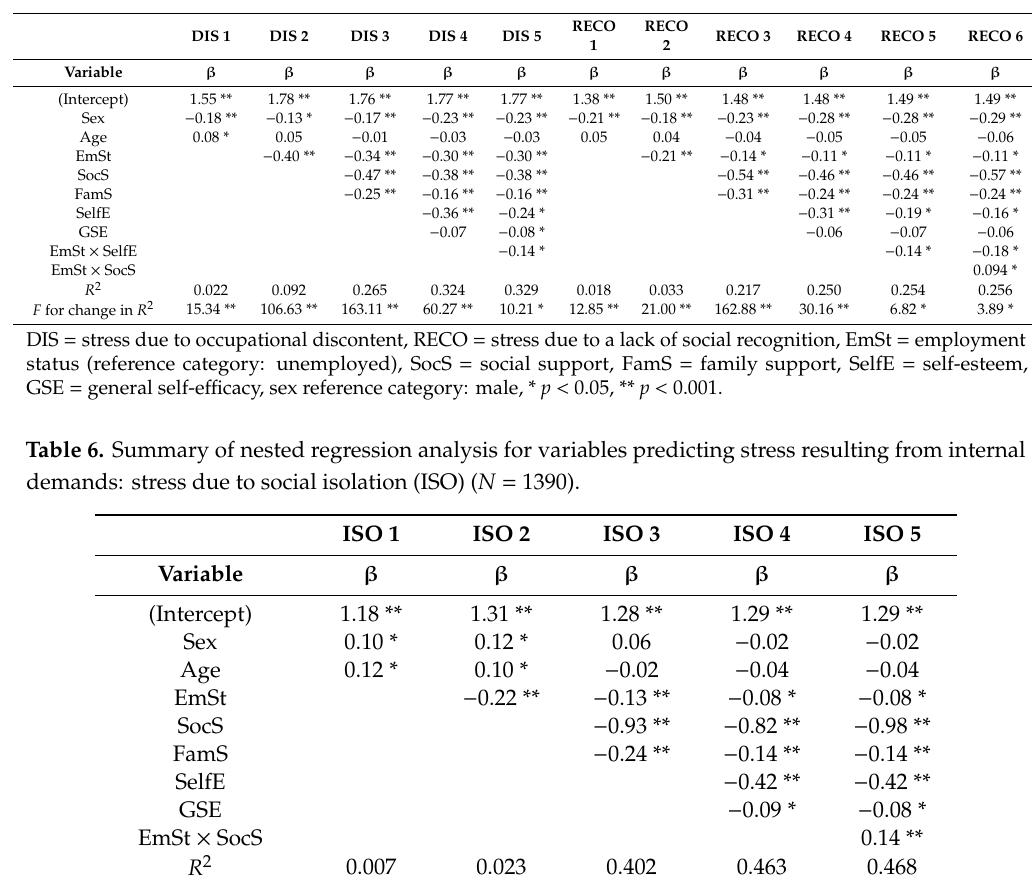
ISO = stress due to social isolation, EmSt = employment status (reference category: unemployed), SocS = social support, FamS = family support, SelfE = self-esteem, GSE = general self-e ffi cacy, sex reference category: male, * p < 0.05, ** p <